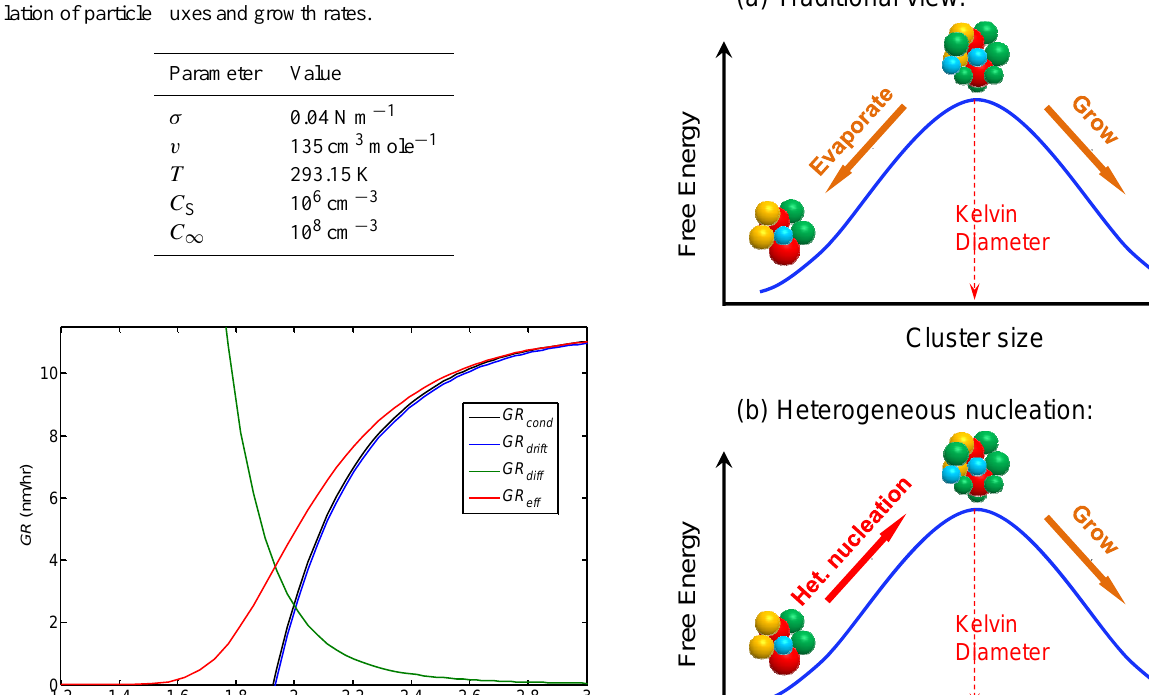
Table 1. Parameter values for model organic species used in calcu- lation of particle fluxes and growth rates.